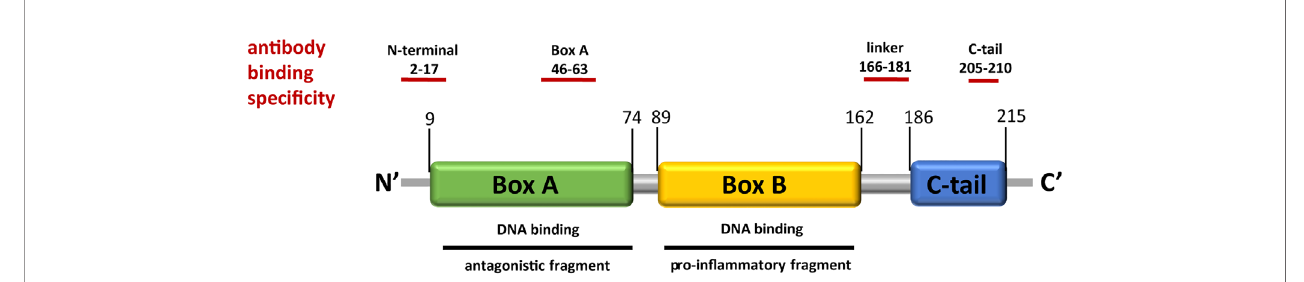
FIGURE 1 | HMGB1 structure indicating functional domains and antibody epitopes. HMGB1 is a 25-kDa protein with a helical structure and consists of two DNA binding domains, box A and box B, as well as an acidic C-tail which can interfere with DNA binding. Different regions of the protein are ligands to immune receptors. While box B is known to have cytokine-like activity, free box A has been shown to act as an antagonist. Several antibodies have been developed to target different epitopes of HMGB1, those used in this study are indicated